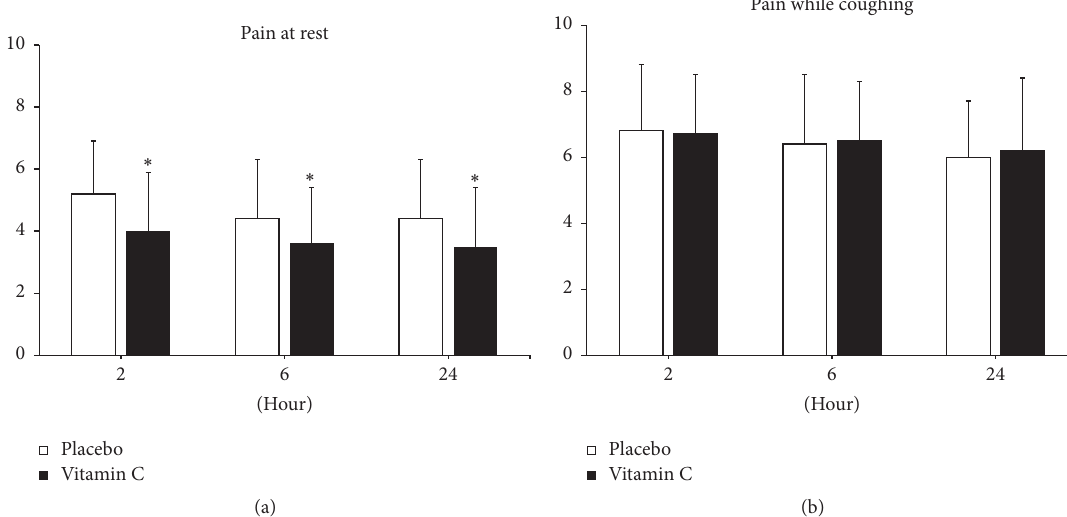
Figure 2: Pain scores at rest (a) and during coughing (b) by numeric rating scale at 2, 6, and 24 h after surgery (mean ± standard deviation). ∗ 𝑃 < 0.05 .